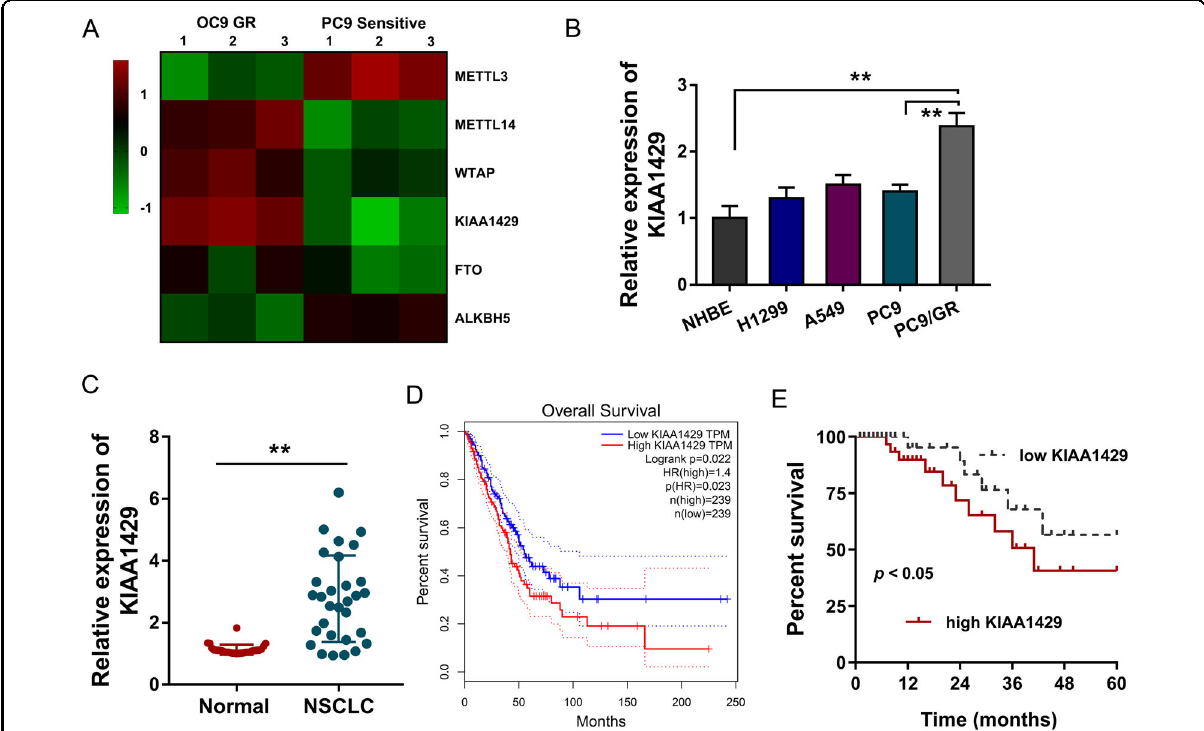
Fig. 1 m 6 A methyltransferase KIAA1429 was upregulated in lung cancer specimens. A Heatmap showed the expression of several candidate m 6 A regulators in ge fi tinib-resistant NSCLC cell (PC9-GR) and parental sensitive cells (PC9). B RT-qPCR showed the KIAA1429 mRNA expression in the ge fi tinib-resistant NSCLC cell (PC9-GR) and other NSCLC cell lines (H1299, A549, and PC9). C RT-qPCR detected the KIAA1429 expression in NSCLC patients ’ samples as compared to normal tissue samples. D Survival analysis based on TCGA database (http://gepia.cancer-pku.cn/) for lung cancer patients with high or low KIAA1429 expression. E Survival analysis based on clinical cohort for NSCLC patients with high or low KIAA1429 expression. Bar graphs indicate the means ± SD. * P < 0.05, ** P <